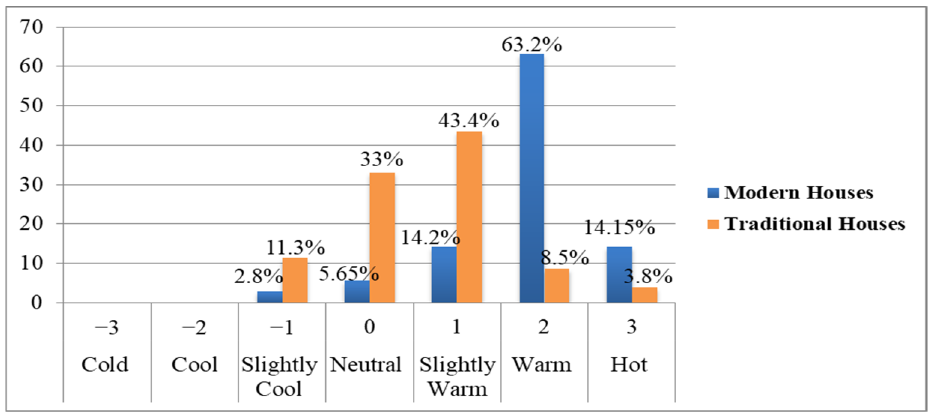
Figure 19. Thermal sensational scales for condominium and traditional houses .